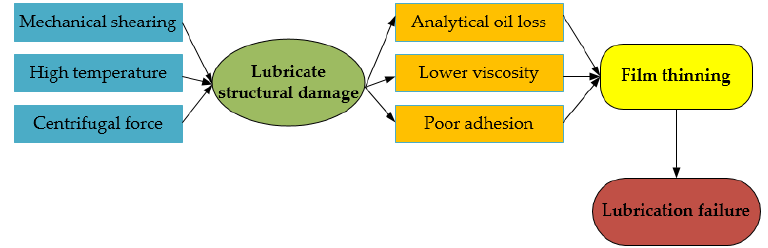
Figure 9. Physical factors of lubrication failure [98,99].